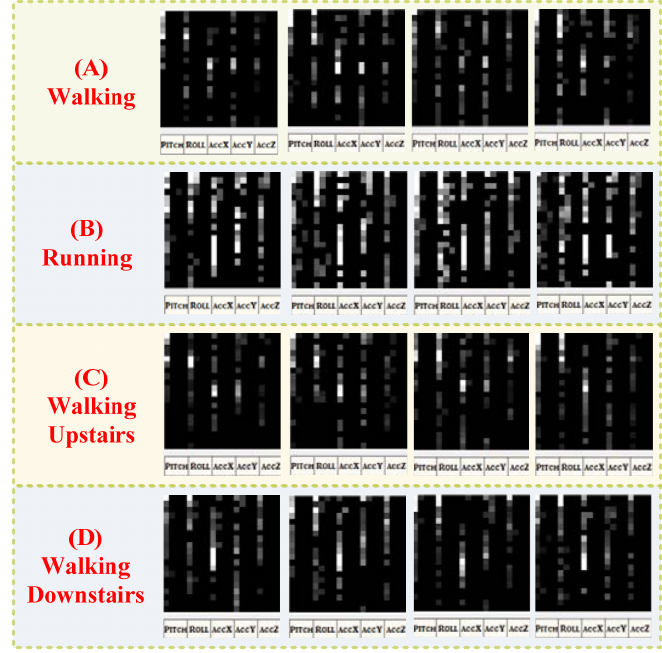
Figure 7. Spectral images of gait in walking, running, walking upstairs, and walking